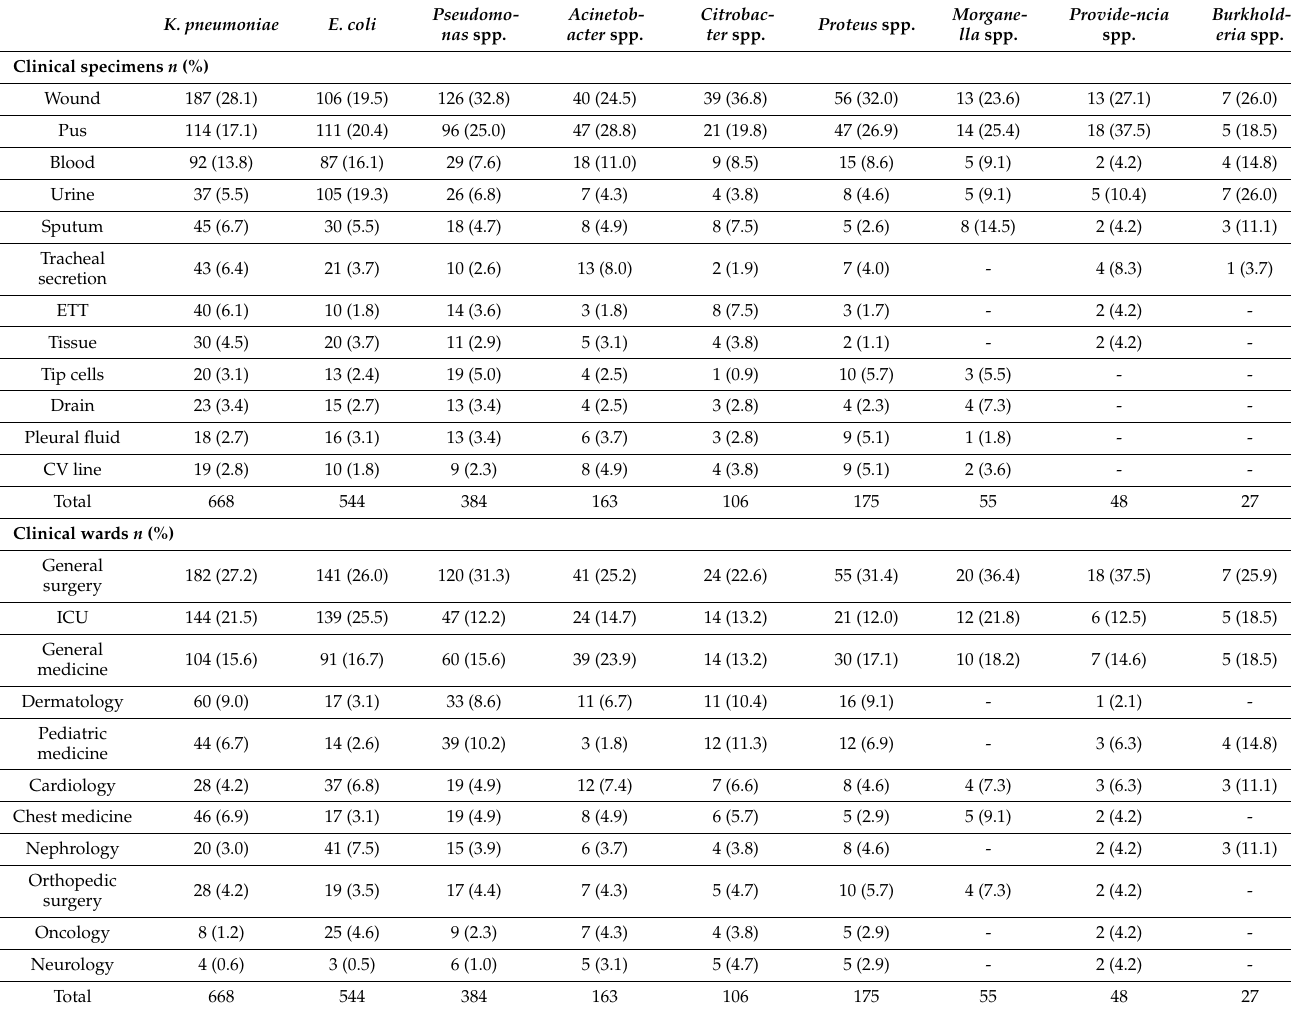
Table 1. Distribution of different species among clinical specimens and